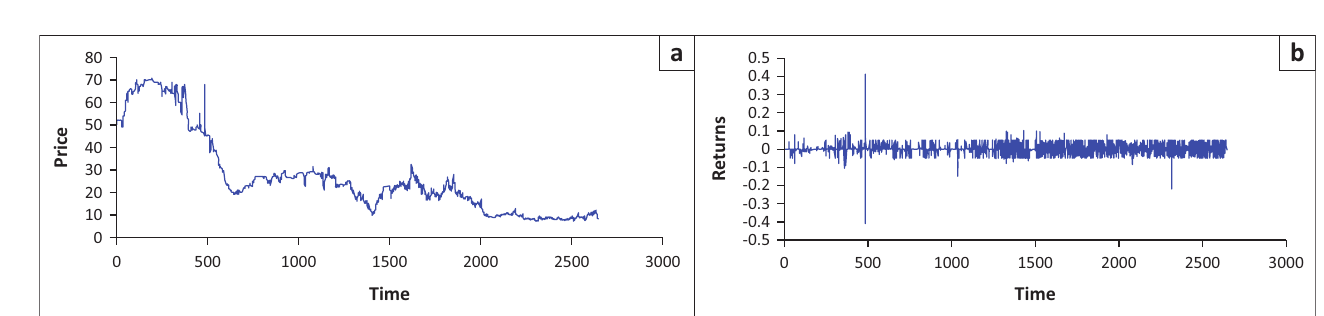
FIGURE 3: JBerger (a) stock pricing over time, (b) returns over time.